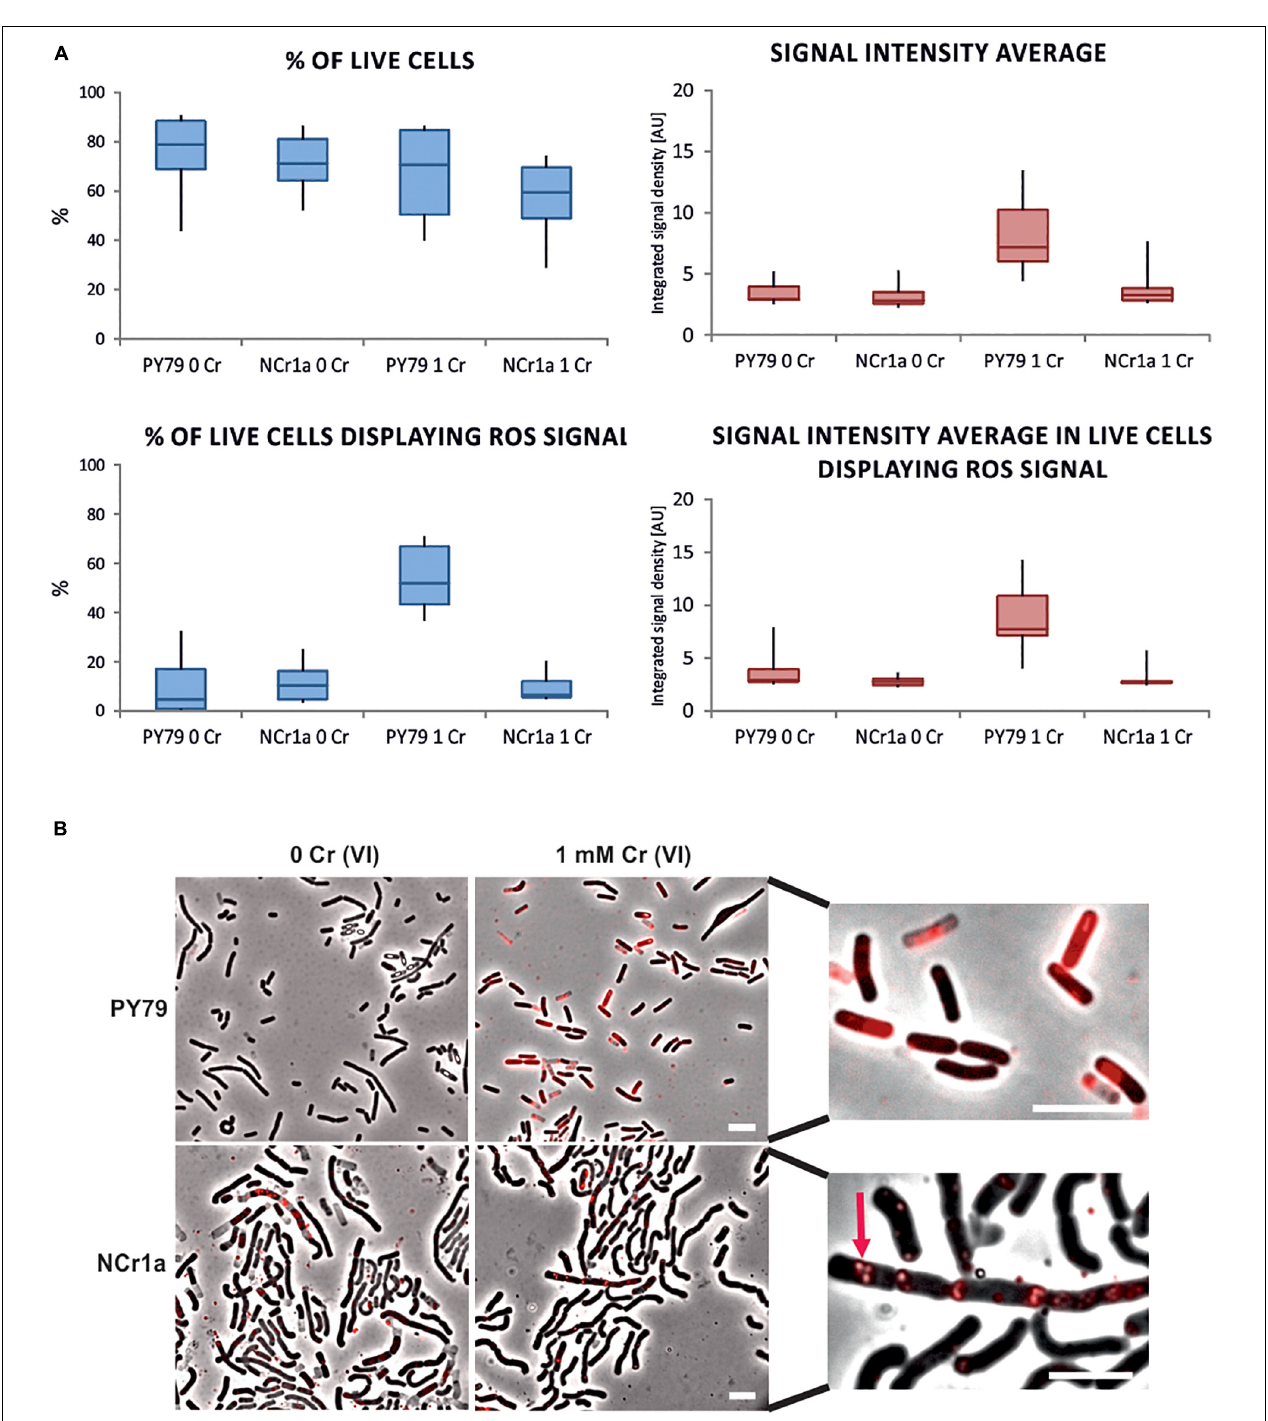
FIGURE 2 | Detection of oxidative stress in cells treated with 1 mM Cr(VI) by fluorescence microscopy. CellROX TM Deep Red Reagent that emits a fluorescence signal upon oxidation was used to visualize the oxidative stress associated with Cr(VI) toxicity in cells of Cr-sensitive PY79 and Cr-tolerant NCr1a. Strains were exposed to 1 mM Cr(VI) for 6 h in minimal liquid media. (A) Differences in survival and signal display between samples of NCr1a and PY79 strains quantified by ImageJ software. Box plots indicate the data range for the sample of each strain grown with or without Cr(VI). At least 3,000 cells were analyzed for each sample. Statistical tests for accepting or rejecting the null hypothesis were employed and respective p -values were obtained. The analyzed characteristics, accurate cell counts, and p -values are summarized in Supplementary Table 4 . (B) Representative fluorescence microscopy images of both strains stained by CellROX TM Deep Red Reagent: without Cr treatment (left) and after incubation with 1 mM Cr(VI) (right). Close-up images of cells stained by CellROX TM Deep Red are on the right side. Arrow marks ROS signal in presumed PHA granules in NCr1a cells. Scale bars represent 5 µ m.